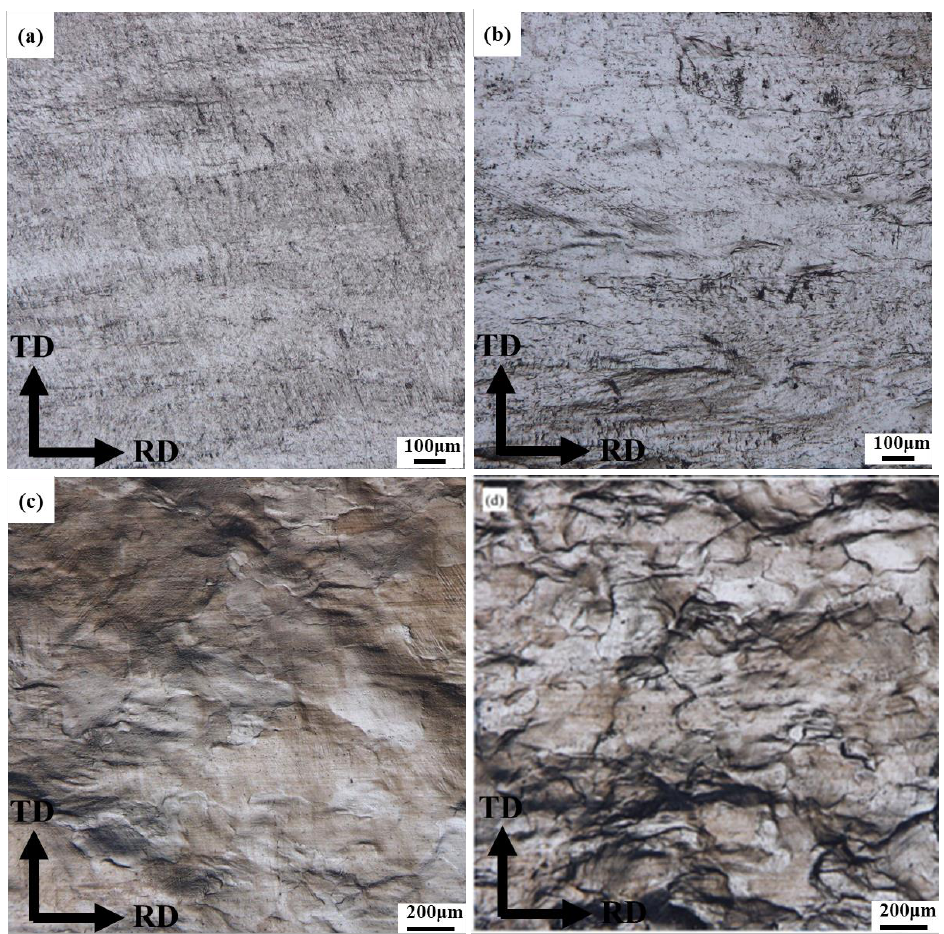
Figure 8. OM images of O-state and W-state alloys tensioned to a fixed strain at 298K and 77K: ( a ) O-state, 298K; ( b ) O-state, 77K; ( c ) W-state, 298K; ( d ) W-state, 77K.